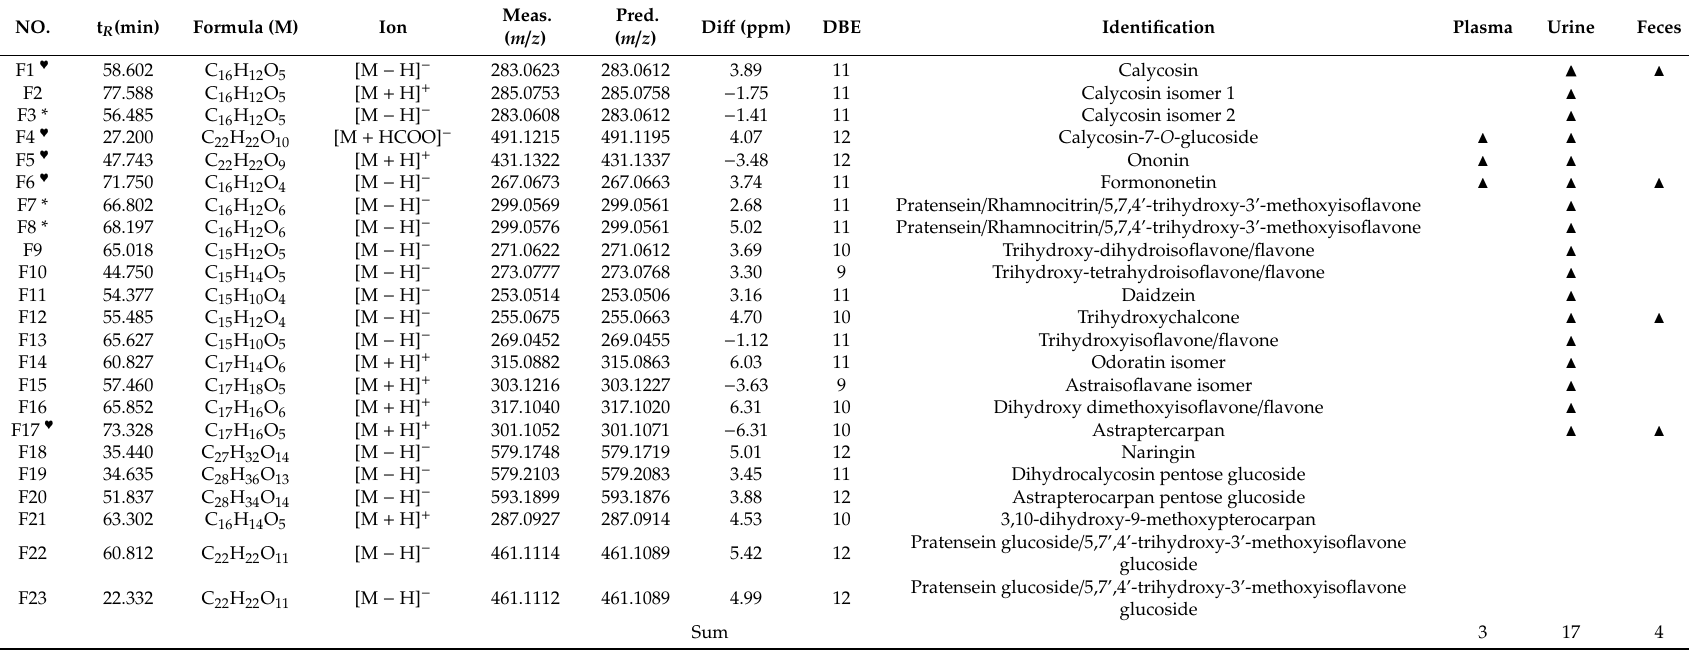
Table 1. Original constituents in vivo after administration of ARTF to